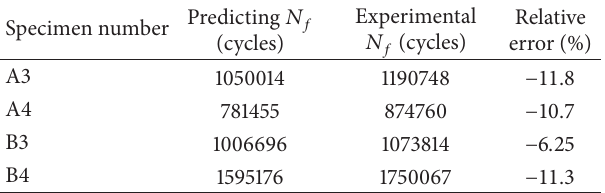
Table 3: Predicting and experimental results of fatigue lives. Predicting 𝑁 𝑓 Specimen number